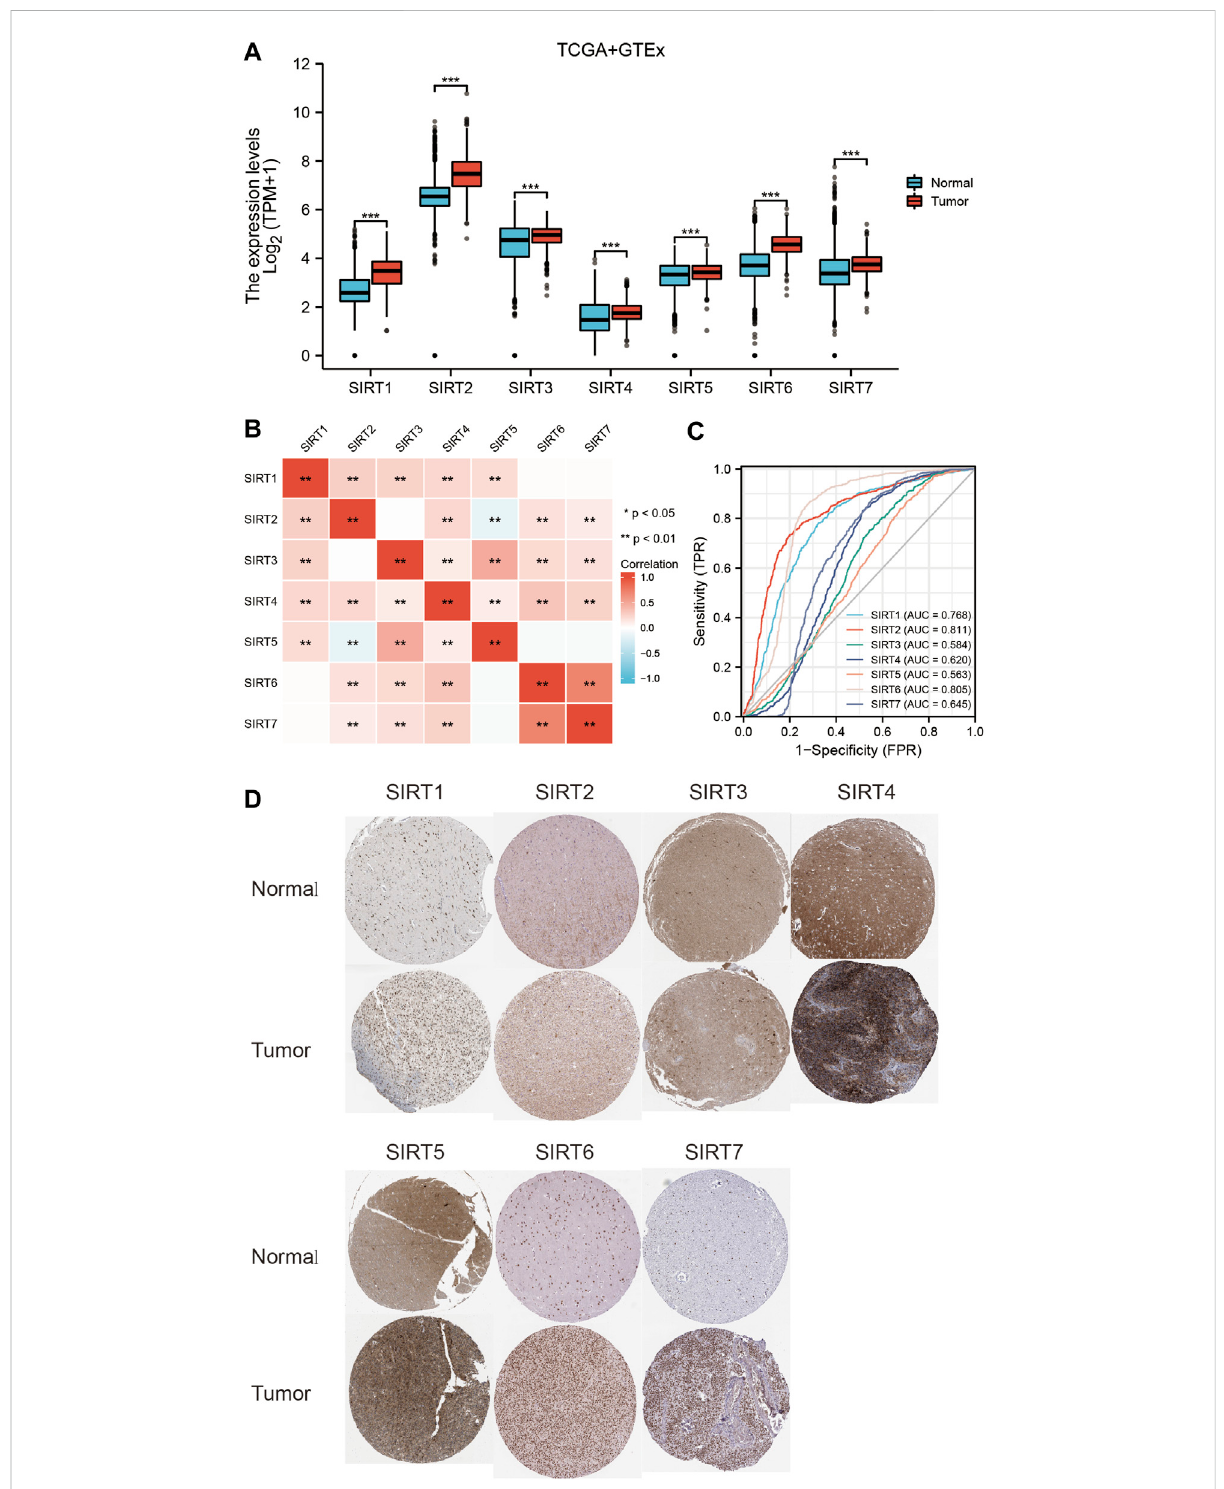
FIGURE 1 Expression levels and diagnostic values of SIRT genes in gliomas. (A) Differential expression of SIRT genes between glioma and normal brain tissues in TCGA and GETx databases. (B) Correlation analysis of SIRT gene expression in glioma tissues of the TCGA database. (C) Diagnostic ROC curves of SIRT genes in TCGA and GETx databases. (D) Expression levels of SIRT genes in glioma vs. normal brain tissues of HPA database (* p < 0.05, ** p < 0.01, *** p < 0.001, ns: p >